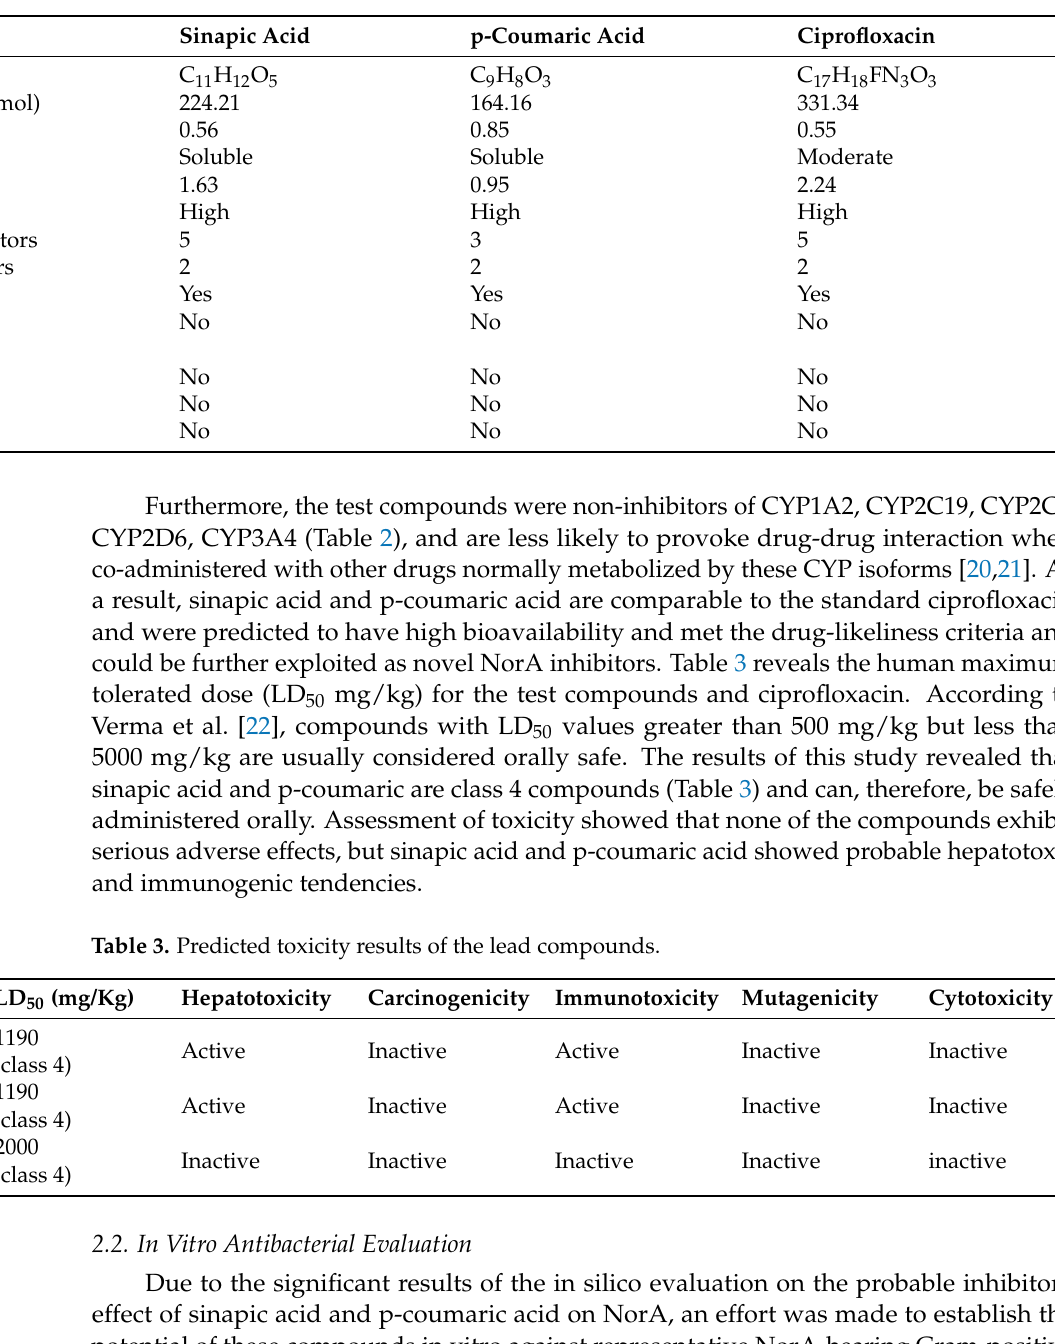
Table 2. ADME properties predicted for the phenolic compounds and drug standard.